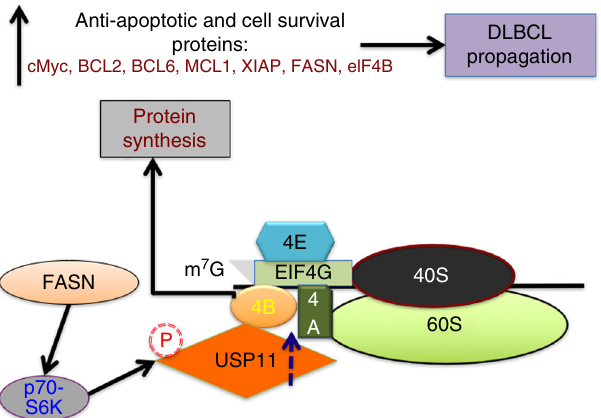
Fig. 9 Oncogenic translation in DLBCL is coordinately regulated by FASN/ eIF4B/USP11 axis. Enhanced FASN activity stimulates S6Kinase to phosphorylate USP11 at Ser 453 . This phospho-modi fi ed USP11 is recruited to translation initiation complex where it interacts, deubiquitinates, and stabilizes eIF4B protein levels. Enhanced eIF4B protein increases mRNA translation of oncoprotein like cMYC, BCL2, BCL6, and others, which are the major drivers for